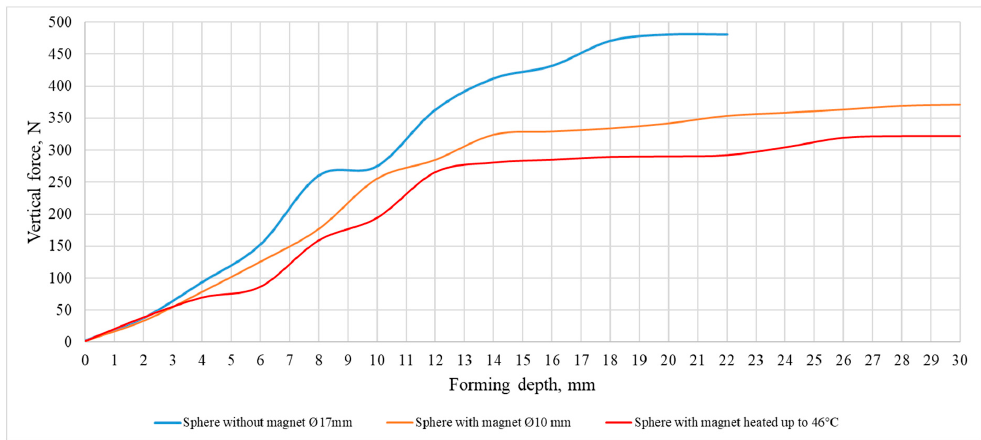
Figure 20. Dependence of the forming force on forming depth.